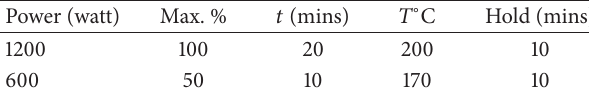
Table 3: Digestion program for ash samples.